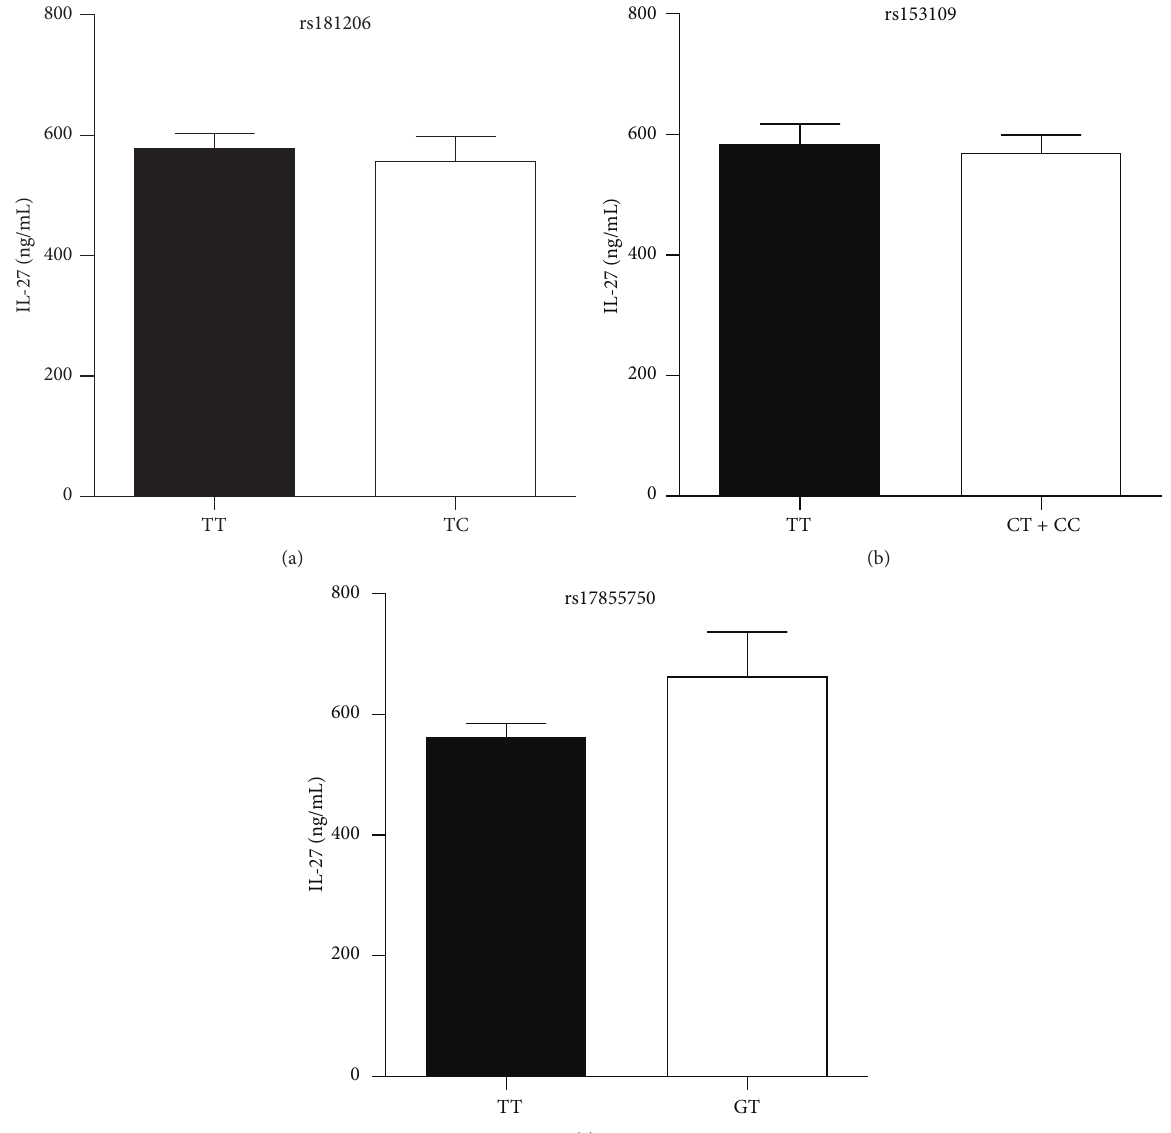
Figure 3: Relationship between serum IL-27 levels and IL27p28 polymorphism in EV71-infected patients. Serum IL-27 levels were measured in 127 individuals for each IL27p28 polymorphism (rs181206, rs153109, and rs17855750) in EV71-infected patients. Values are expressed as means ± SEM. No associations were found between rs181206 (a), rs153109 (b), and rs17855750 (c) and serum IL-27 levels in EV71-infected